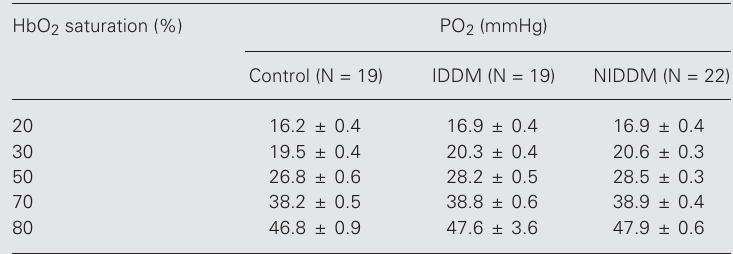
Table 1. Relationships between hemoglobin-oxygen (HbO 2 ) saturation and partial oxygen pressure (PO 2 ) for the three groups studied. HbO 2 saturation (%)